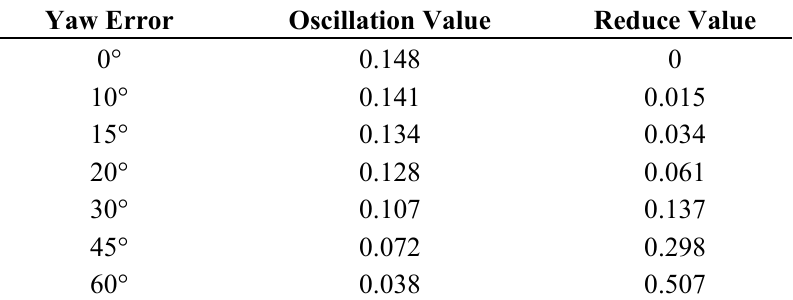
Figure 8. Effects of yaw error on P c . Table 6. Values of P c oscillation.